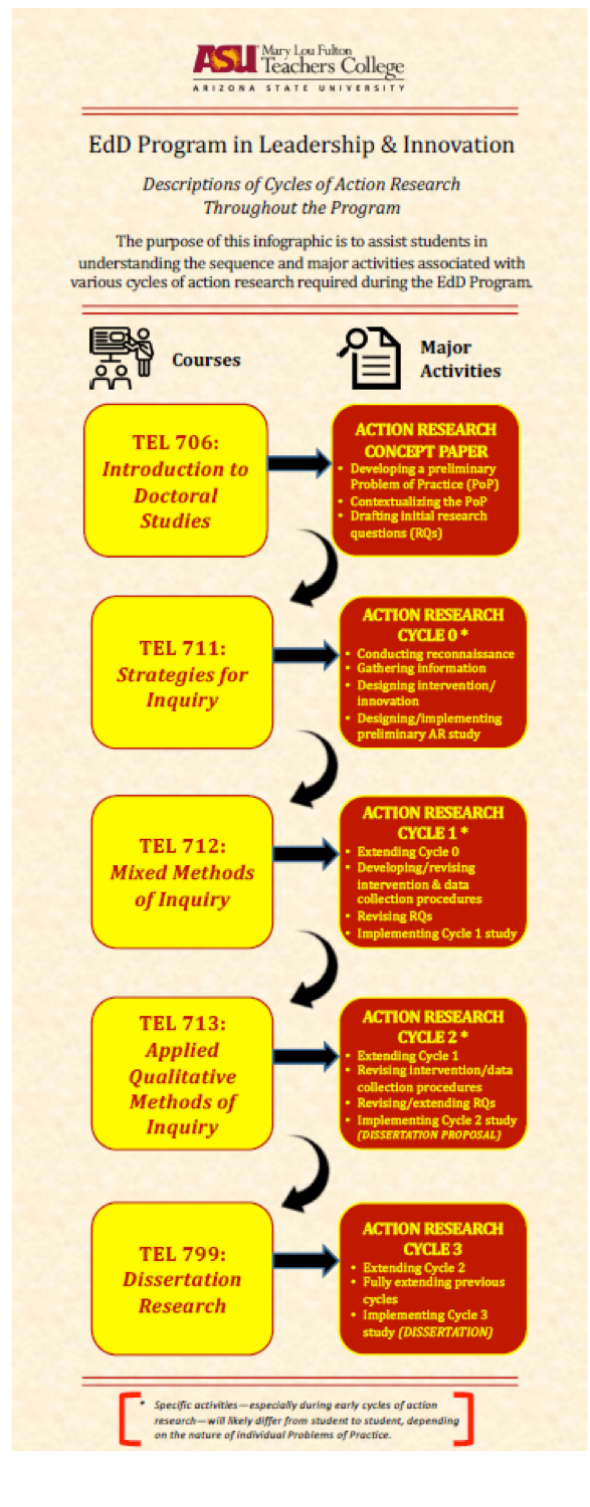
Figure 1. Cycles of AR in Arizona State University’s EdD Program in Leadership and